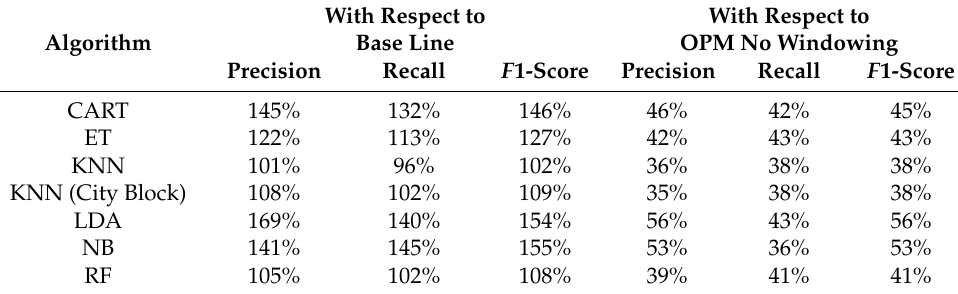
Table 5. Percentage increase in accuracy.